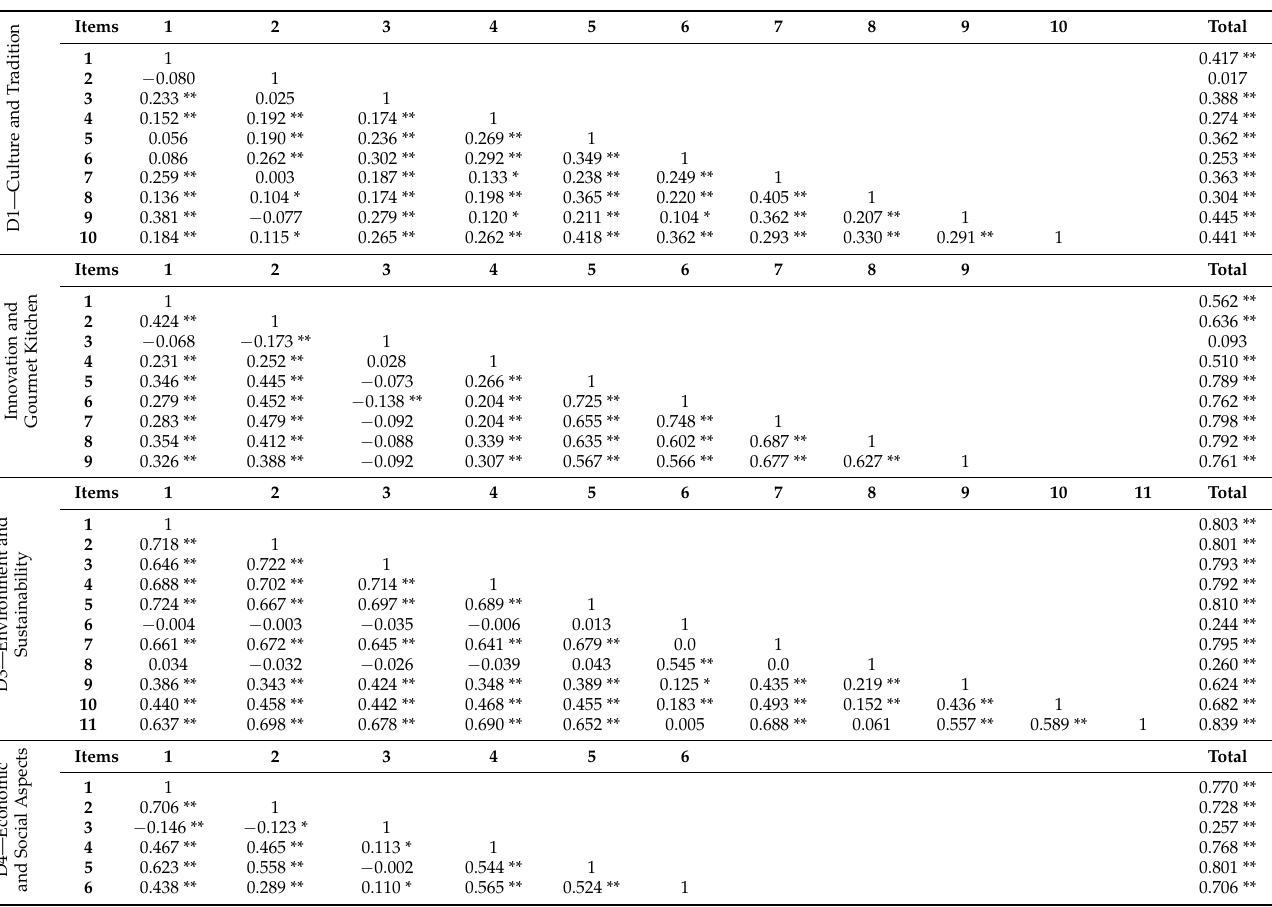
Table 1. Item analysis to the seven subscales (Pearson correlations item–item and